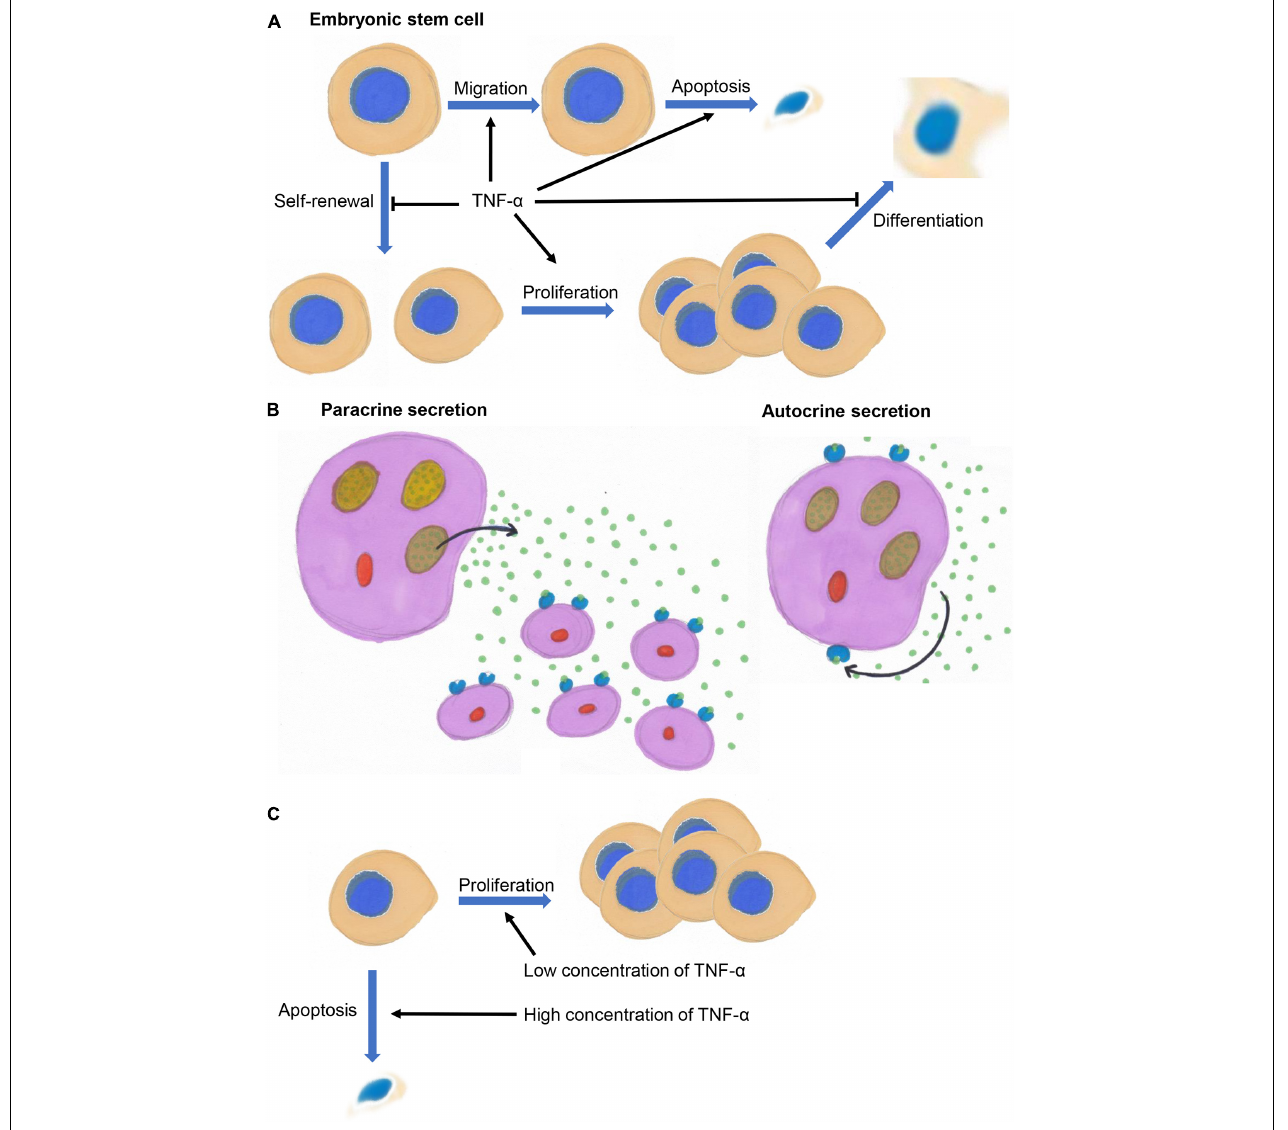
FIGURE 2 | (A) TNF- α inhibits the self-renewal of embryonic stem cells and promotes their migration, and inhibits the differentiation of progenitor cells and promotes their proliferation and survival. (B) TNF- α acts on its secreting cells (autocrine signaling) or surrounding cells (paracrine signaling). (C) TNF- α promotes cell proliferation at low concentrations and inhibit cell proliferation and induce apoptosis at high